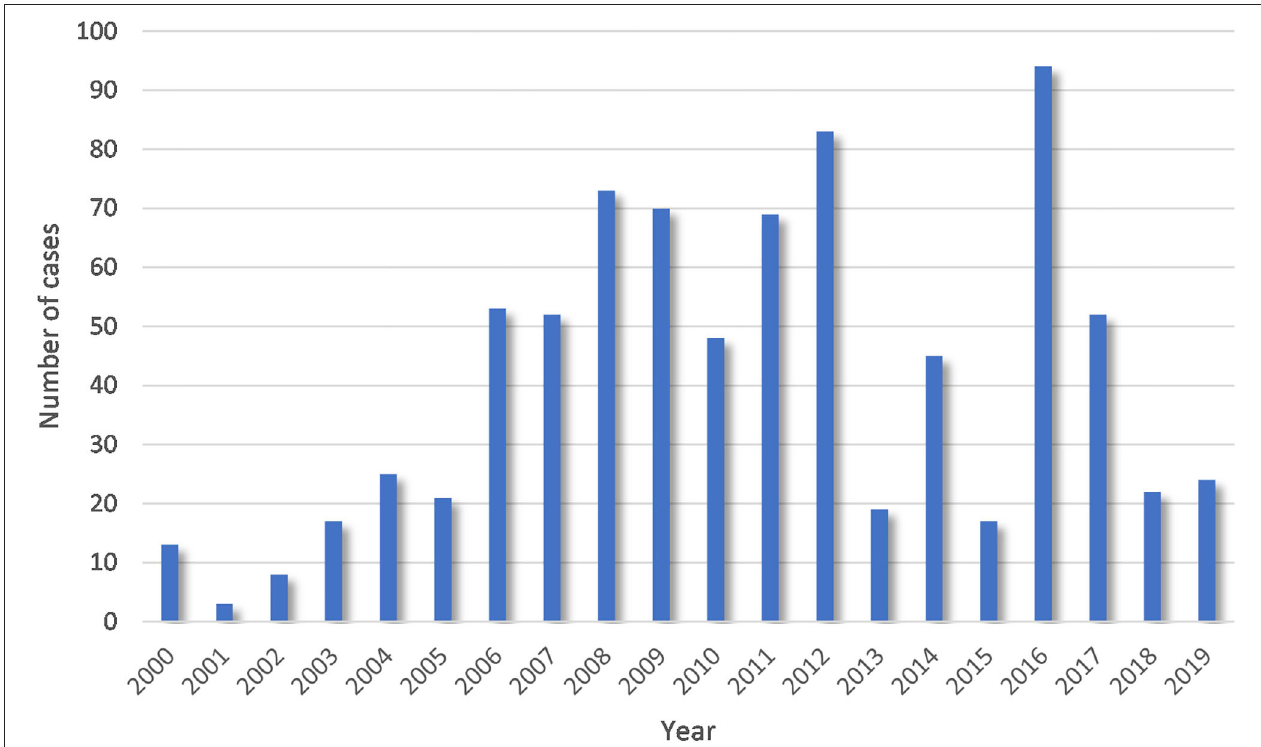
FIGURE 2 | Yearly distribution of livestock leptospirosis cases for the period from 2000 to